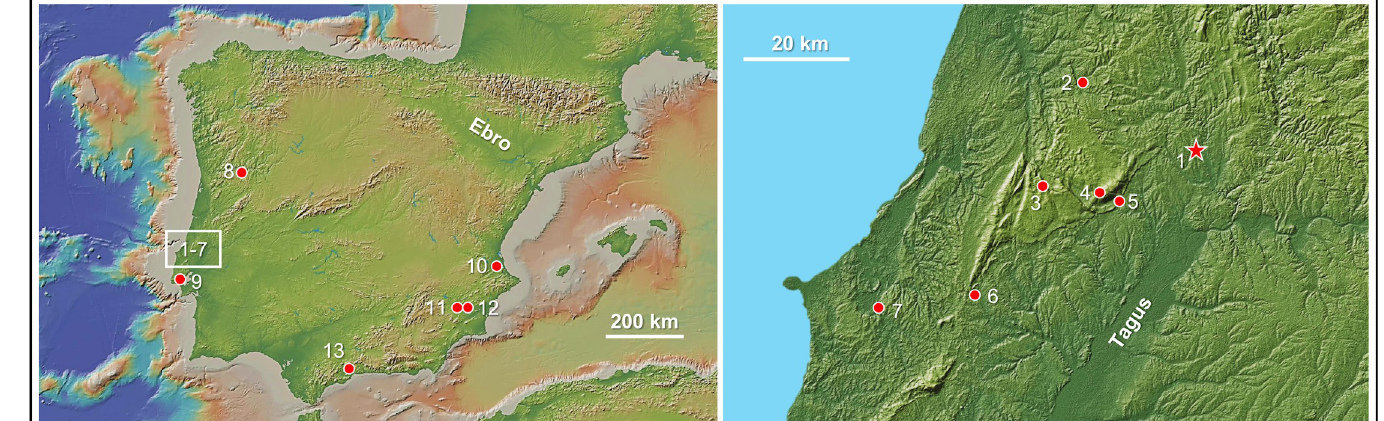
Fig 1. Location of the sites mentioned in the text. 1. Gruta do Caldeir ã o. 2. Abrigo do Lagar Velho; 3. Lapa do Anecrial; 4. Lapa do Picareiro; 5. Gruta da Oliveira; 6. Gato Preto; 7. Gruta Nova da Columbeira; 8. Cardina/Salto do Boi; 9. Pego do Diabo; 10. Cova de Malladetes; 11. Cueva Anto´n; 12. Fica Do ñ a Martina and Abrigo de La Boja (Rambla Perea). 13. Cueva Bajondillo. Relief map: Global Multi-Resolution Topography Synthesis (https://www.gmrt.org/GMRTMapTool/). Reproduced from [5] under a CC BY 4.0 license.